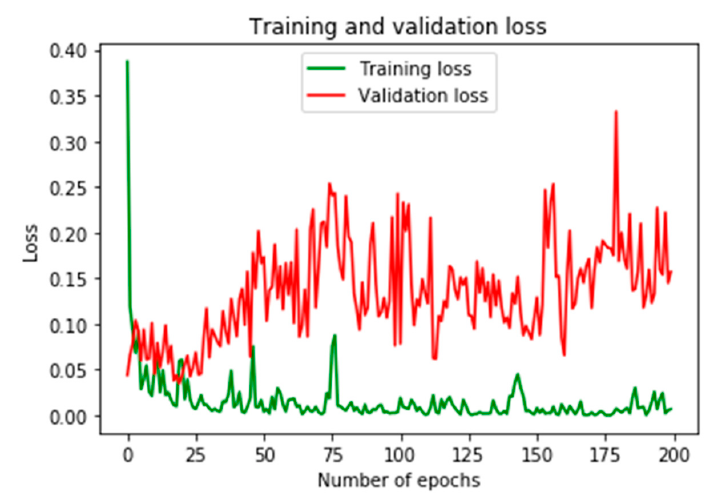
Figure 9. Showing training and validation losses using ResNet50.